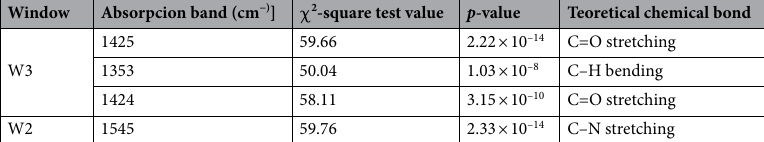
Table 6. Best predictors for differentiation of CHD patients infected with H. pylori .